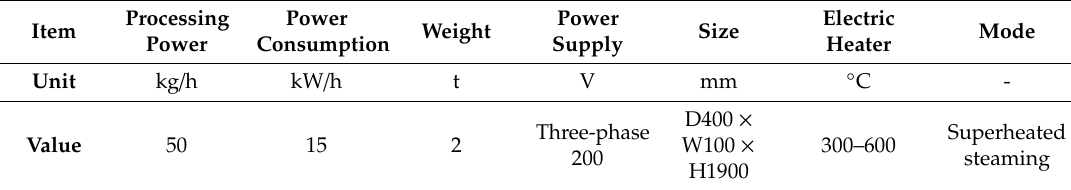
Table 1. Specifications of torrefaction equipment.